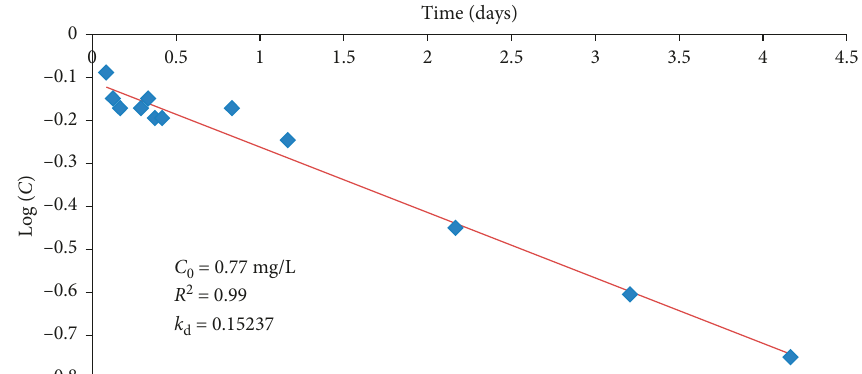
Figure 1: Linearised plot of chlorine residual with the initial chlorine dose of 0.77mg/L.